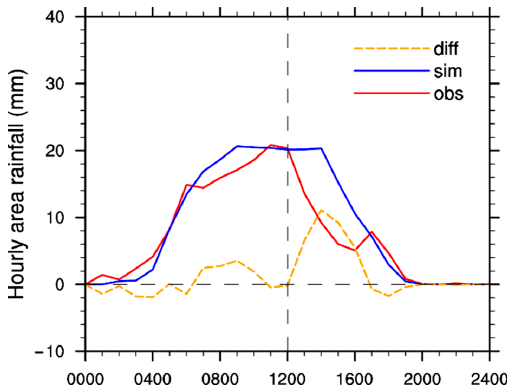
Figure 3. The observed ( a1 , a2 ) and 3-km simulated ( b1 , b2 ) and 1-km simulated ( c1 , c2 ) 6-h cumulative precipitation (shaded, units: mm) and the geopotential height (blue contours, units: 10 gpm) at 700 hPa during the period 0000–0600 UTC ( a1 – c1 ) and 0600–1200 UTC ( a2 – c2 ) 21 July 2012. The black star denotes the location of Beijing. Atmosphere 2020 , 11 , x FOR PEER REVIEW